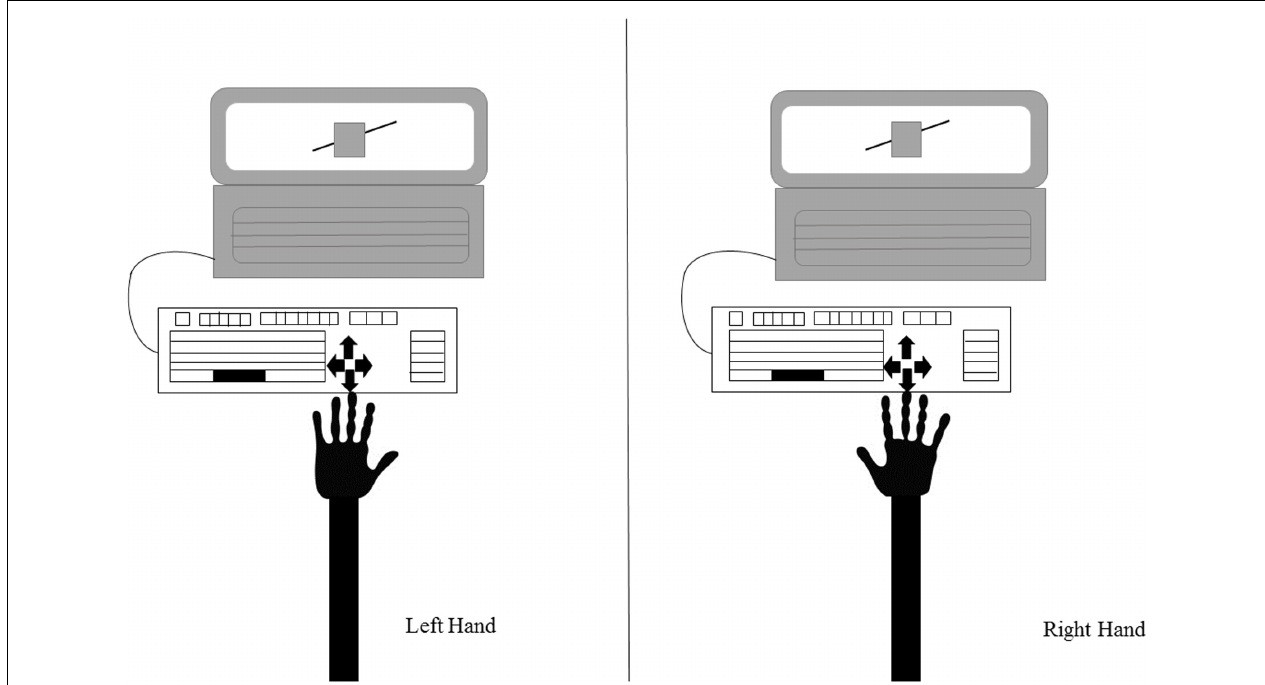
FIGURE 2 | Representation of the study setup. The participant is seated in front of the laptop showing the experimental stimuli (in this example, the Poggendorff illusion). An external keyboard is attached to the laptop to ensure the body midline is not crossed. The figure shows the keyboard and the position of the arrows used to respond: as it can be seen, this setup allows responses with both hands maintaining the same spatial alignment with the